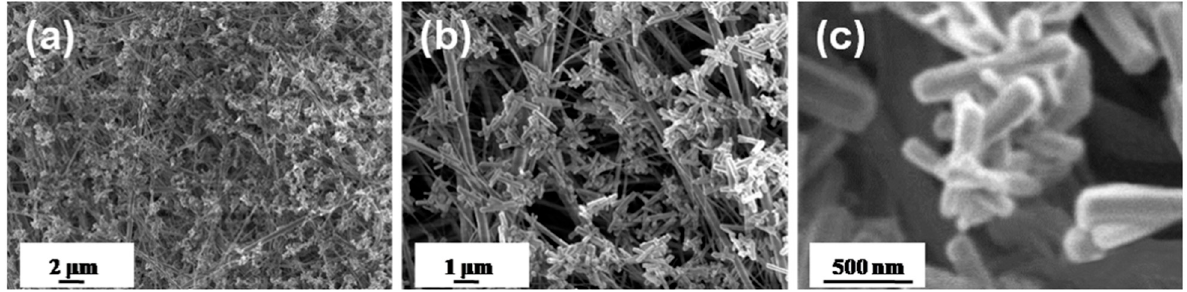
Figure 1. SEM images of ZnO@GMF substrates at different resolutions ( a ) 2 μ m, ( b ) 1 μ m, ( c ) 500 nm, respectively.